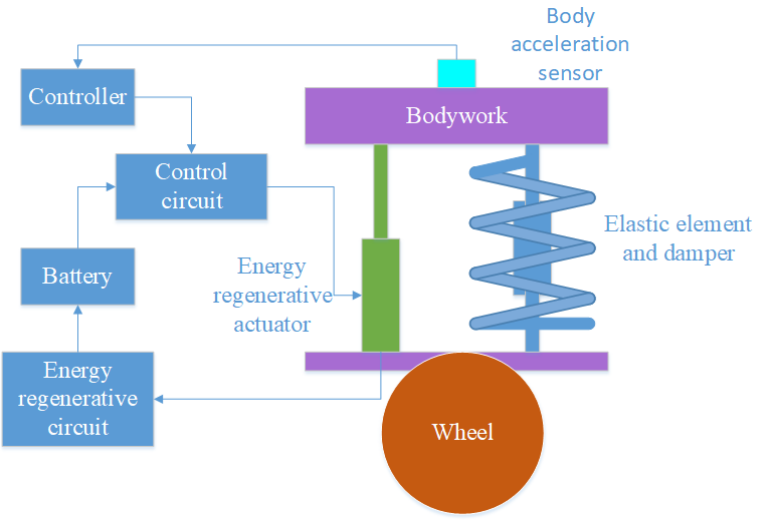
Figure 2. Structure of the 1/4 energy regenerative active suspension.